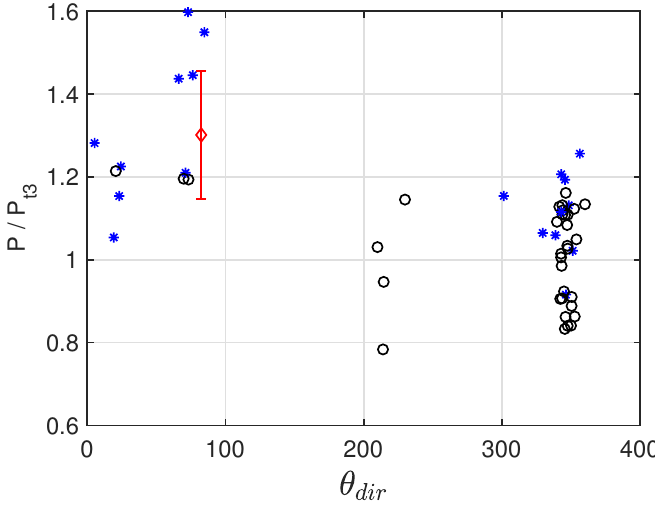
Figure 10. Wave direction Θ (coming-from) versus probability of extreme waves normalized with the Tayfun third-order probability P / P t 3 . Blue stars ∗ denote crossing seas. The red diamond (cid:5) indicates case #16 (Louis Majesty accident), with error bars indicating a 95% confidence